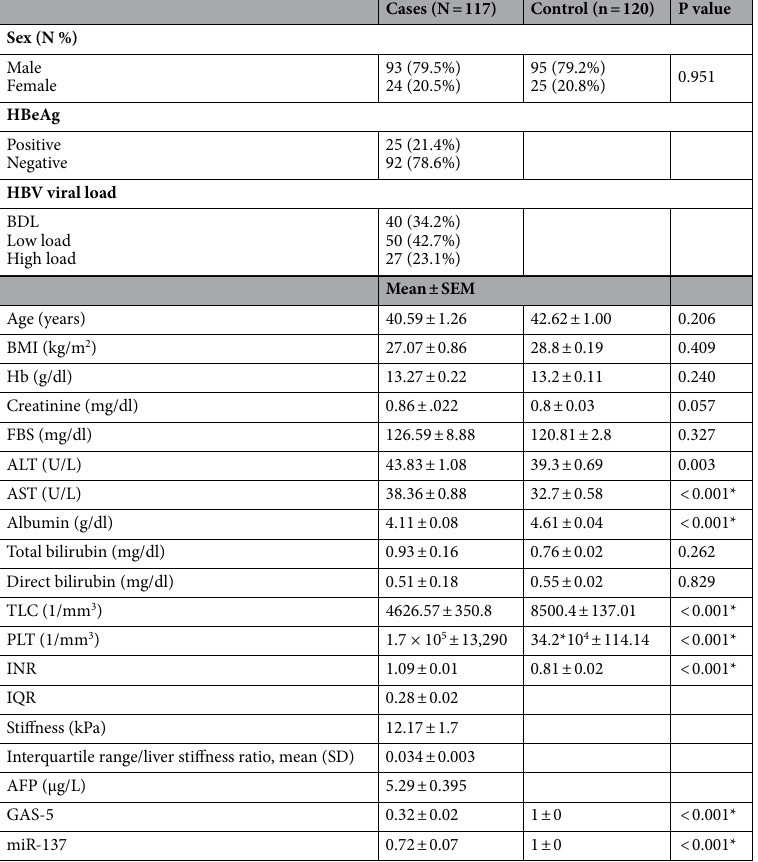
factor for CHBV as regards the recessive model (TT vs GG + GT), [OR (95%CI), 19.8 (9.56–41.1), p < 0.001] (Table 2). Association of serum GAS5 and miR‑137 levels with rs2067079 and rs1625579 in CHBV patients. We evaluated serum expression levels of GAS5 and miR-137 in CHBV patients having the different SNP genotypes to interpret the role of rs2067079 and rs1625579 in this disease (Fig. 3). By studying the effect of rs2067079, we found that the serum GAS5 expression level was significantly higher in the mutant TT genotype carriers vs those with the CT or CC genotypes ( p = 0.007) (Fig. 3a). However, this SNP did not affect the expres- sion level of miR-137 ( p = 0.056) (Fig. 3b). Regarding the rs1625579, we did not find a significant difference in the serum expression of GAS5 among CHBV patients with different rs1625579 genotypes ( p = 0.489) (Fig. 3c). In contrast, serum miR-137 expression level was significantly down-regulated with the mutant TT genotype versus GT and GG genotypes among CHBV patients ( p = 0.018) (Fig. 3d).